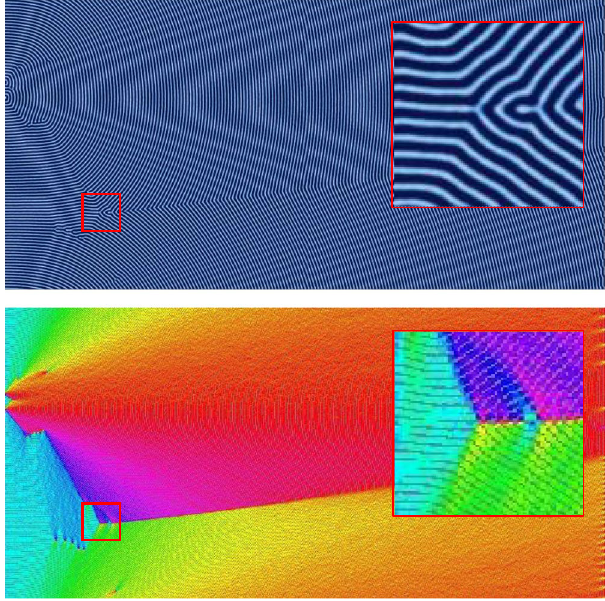
Figure 4. Same as Fig. 3 with a higher zone velocity of v zone = 0.0645. Extended defects similar to grain boundaries emerge and generally extend from left to right in the direction of the zone translation.